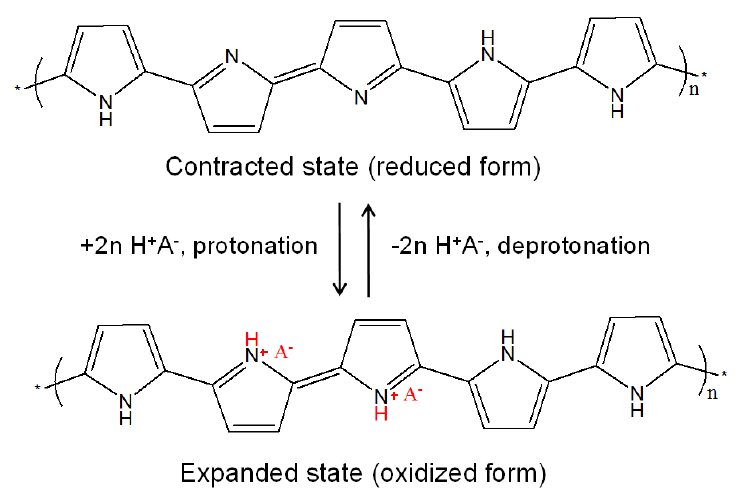
Figure 1. Chemical structures of polypyrrole (PPy) in different chemical states.